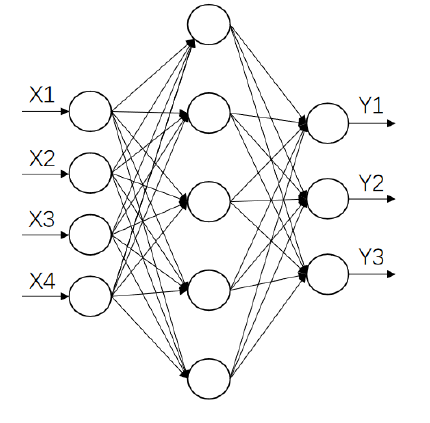
Figure 8. BP neural network structure